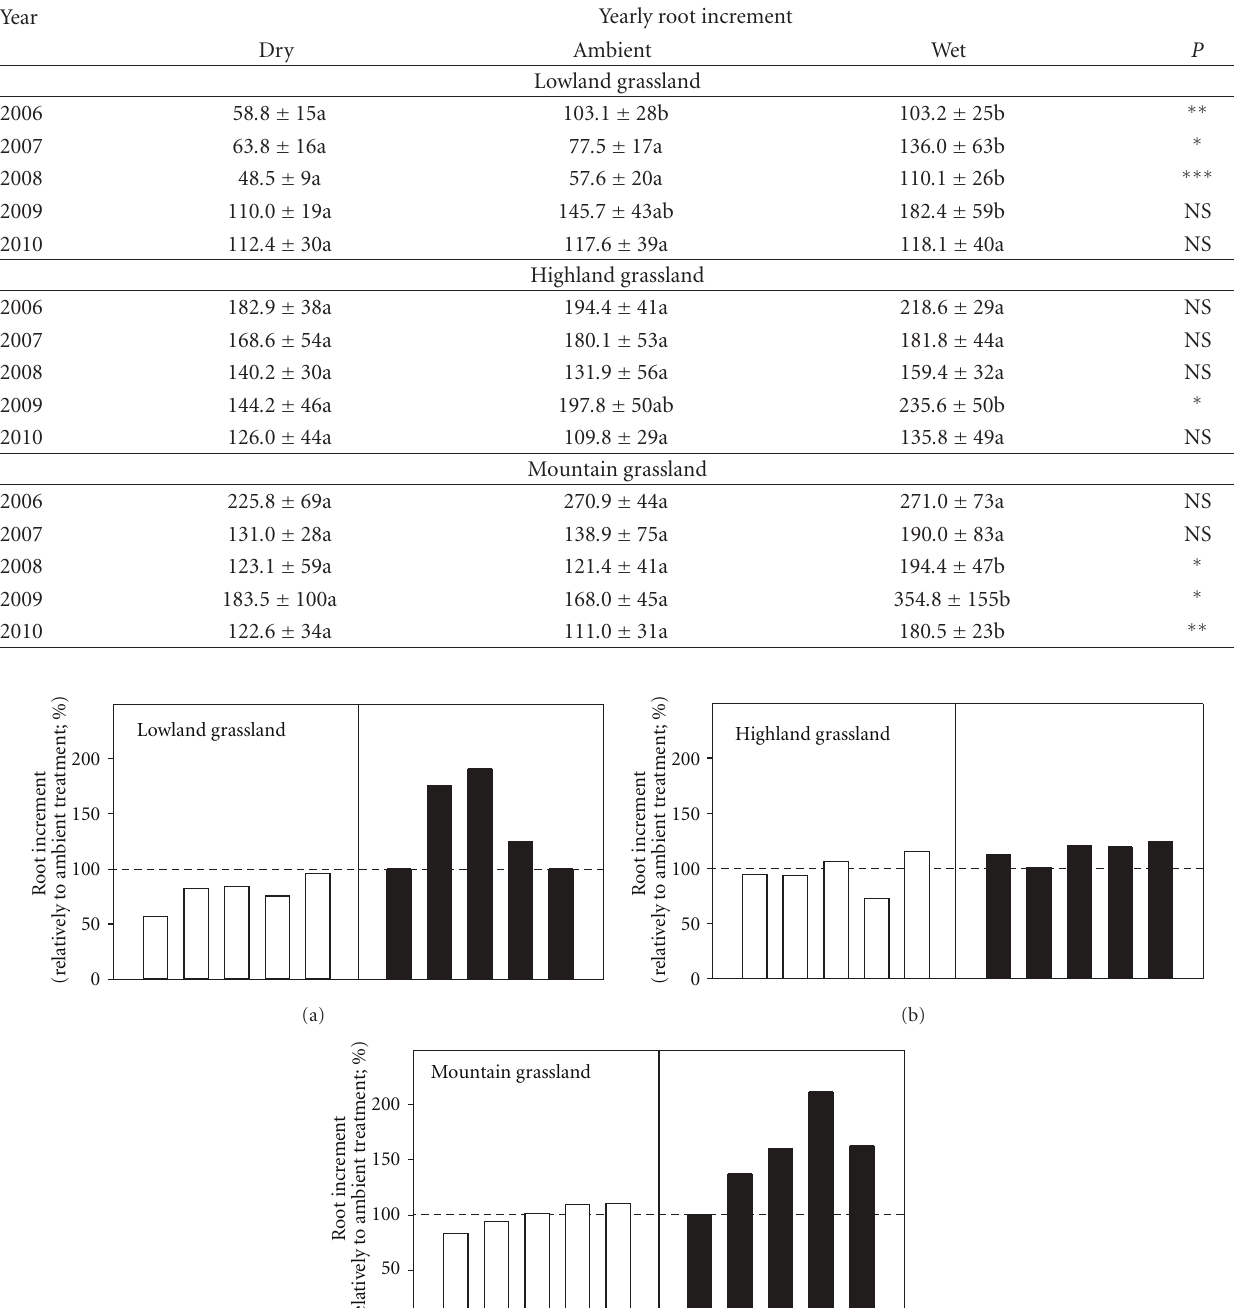
Table 4: Mean values ( ± SE) of yearly root increment under di ff erent amounts of precipitation (dry, ambient, and wet treatments) recorded in five years (2006–2010): results of one-way ANOVA analysis (NS: not significant, ∗ P < 0 . 05, ∗∗ P < 0 . 01, ∗∗∗ P < 0 . 001). Di ff erent letters denote significantly di ff erent values for rhizomes, roots, and total separately (Tukey HSD test ( P < 0 . 05) after ANOVA).